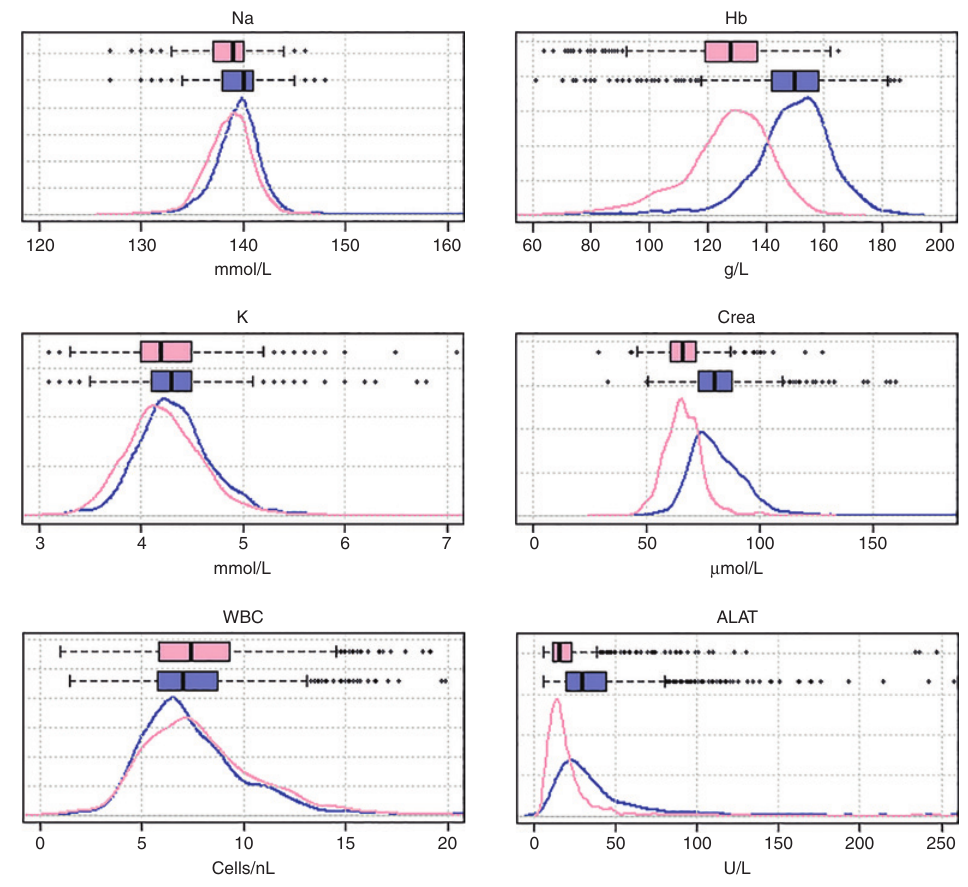
Figure 3: Density and boxplots for routine laboratory results in women (pink) and men (blue).